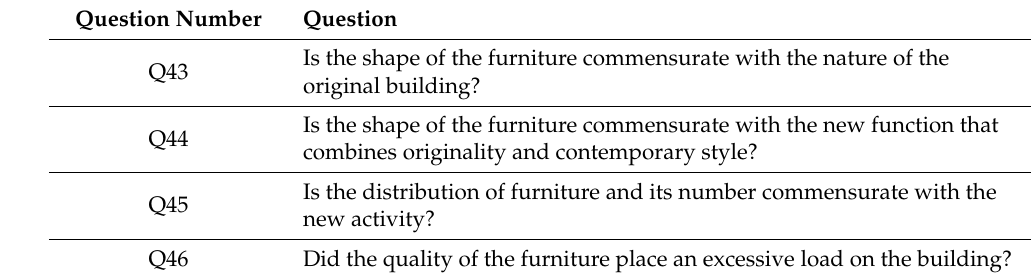
Table 8. Interior design questions (furniture).